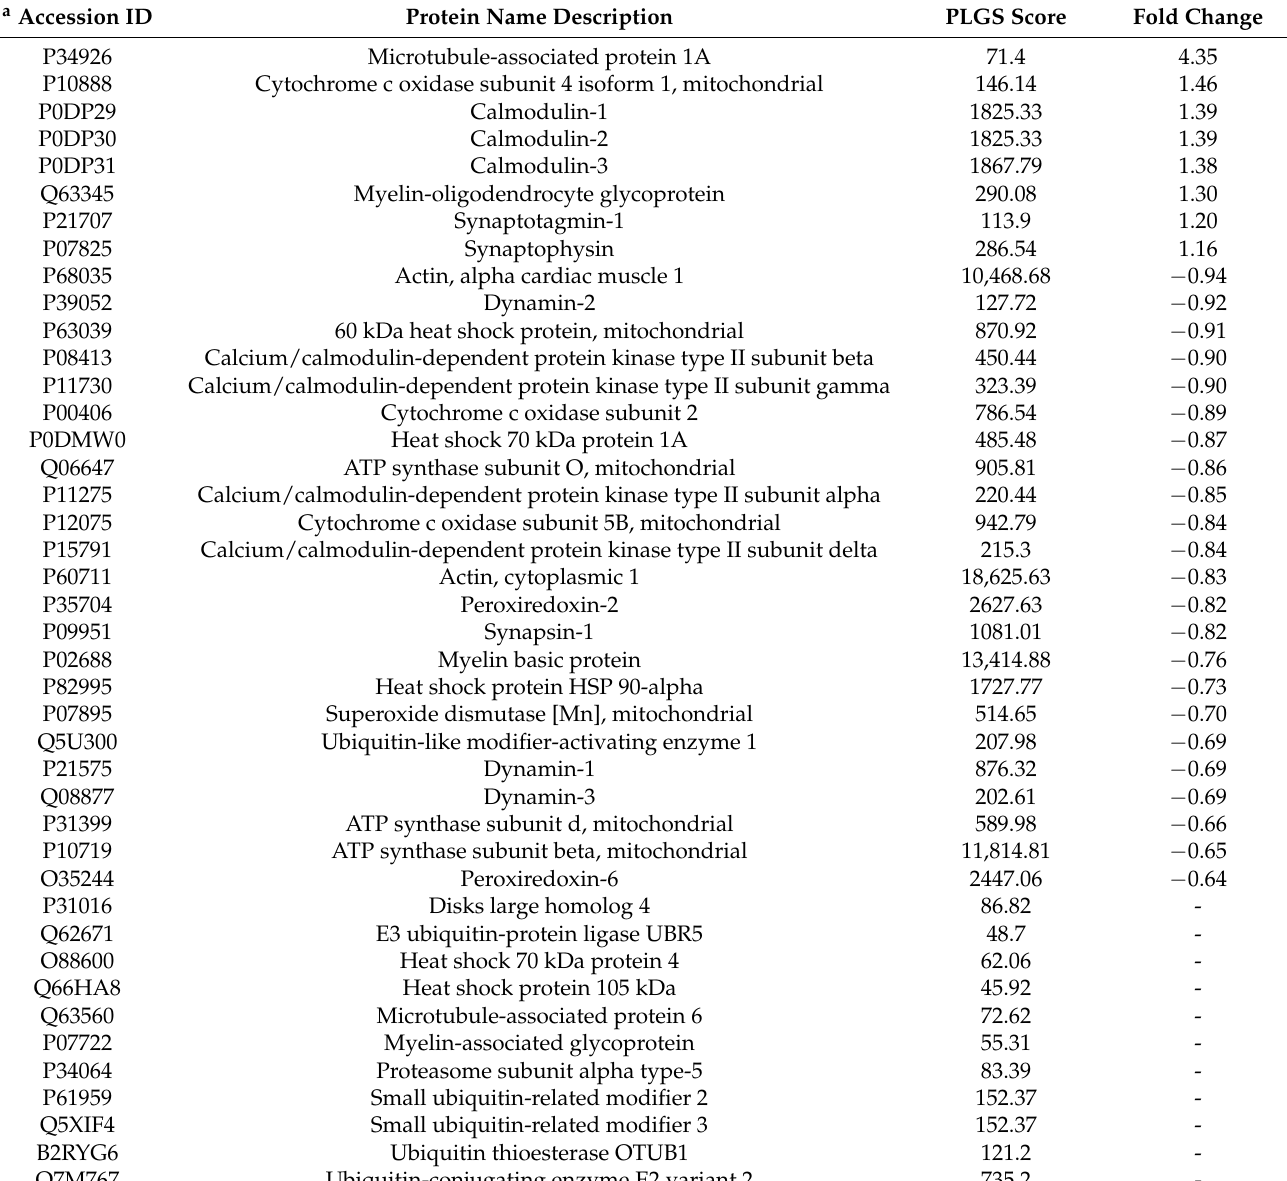
Table 1. Identified proteins with expression significantly altered in the cerebellum of rats of the IHg group versus control